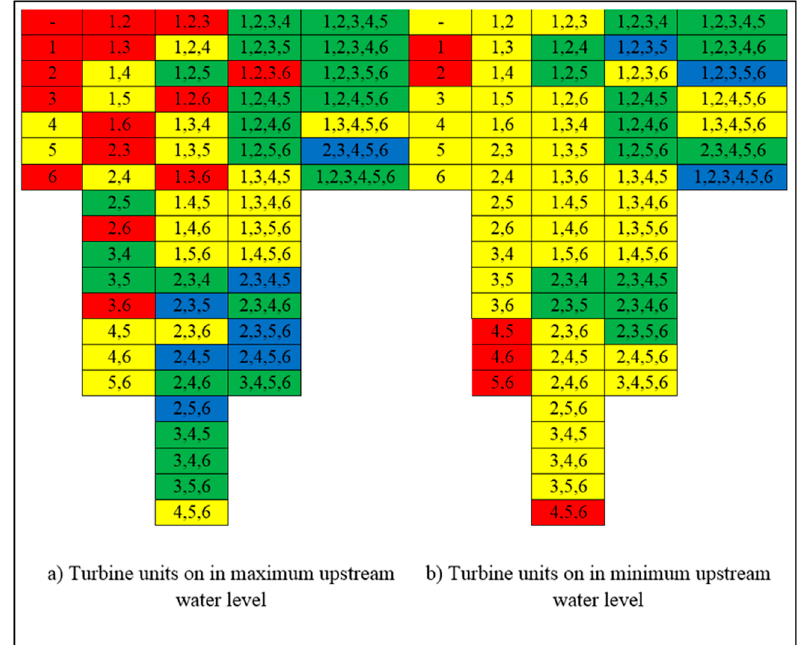
Figure 10. Control program for the running turbines in the Haditha powerhouse based on minimizing the principal stress.